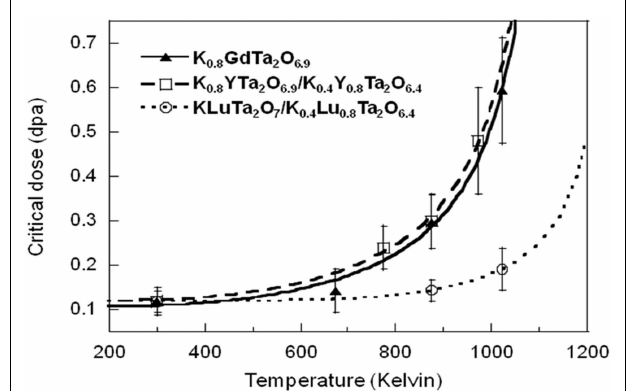
FIGURE 5 |Temperature dependence of the critical amorphization dose of the K x Ln y Ta 2 O 7-v samples .